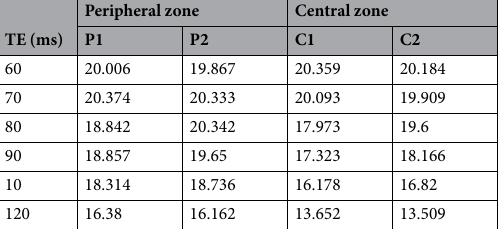
Table 6. Signal-to-noise ratio at b = 1000 s/mm 2 . Note: P peripheral zone; C central zone; 1 the measurement results for the first examination; 2 the measurement results for the second